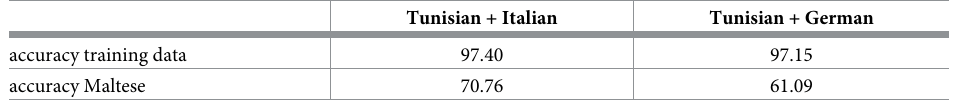
Table 2. Global accuracies of the two NDL models trained on Tunisian and Italian nouns or trained on Tunisian and German nouns; tested on Maltese